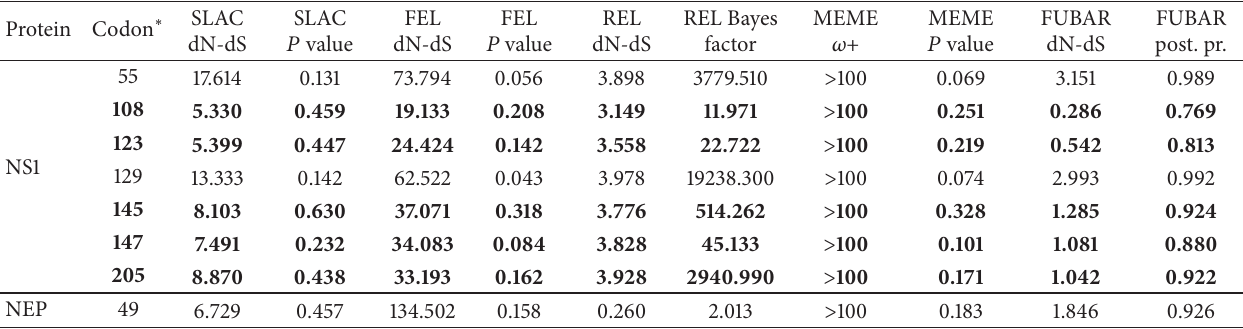
Table 4: Selection pressure analysis of NS1 protein and NEP of H1N1 pdm (09) virus using SLAC, FEL, REL, MEME, and FUBAR methods at